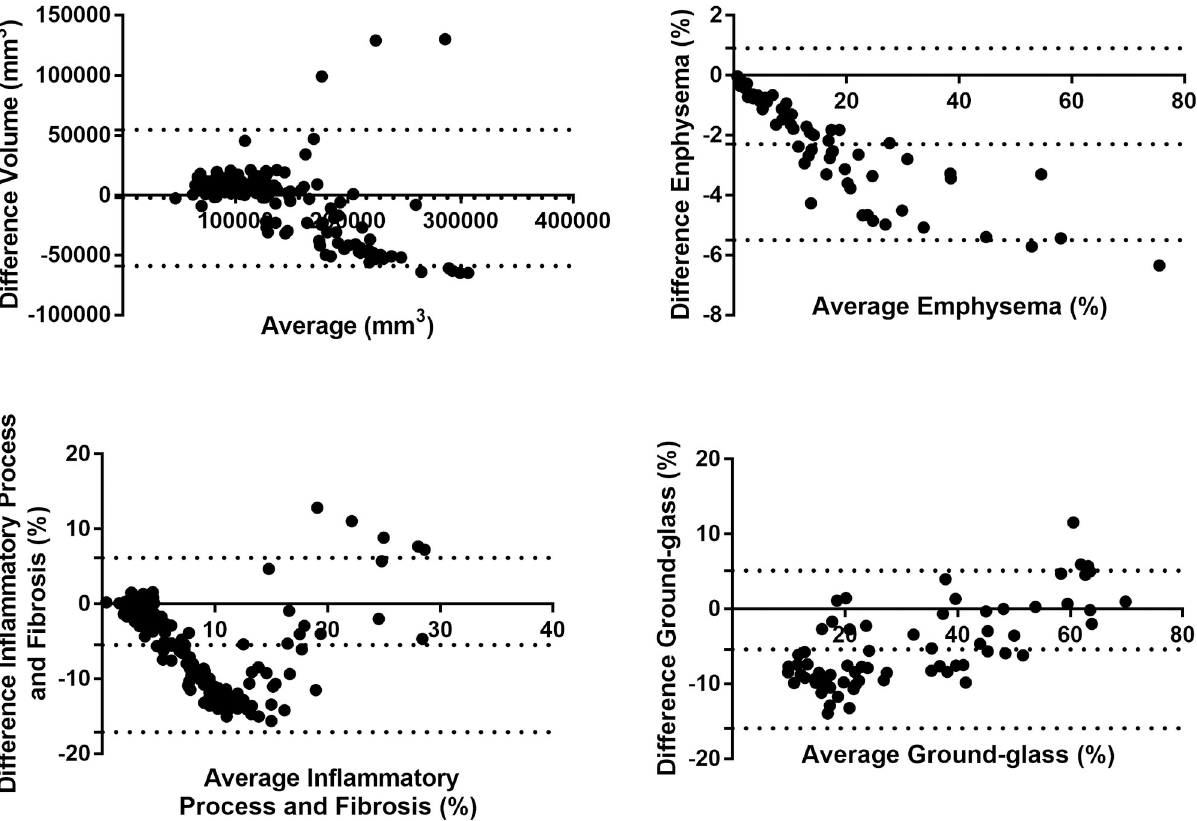
Fig 4. Bland–Altman plots comparing the difference the semi-automatic and the automatic algorithms. A—Lung volume, B—Emphysema, C— Inflammatory process and fibrosis, and D—Ground-glass opacities. Short dashed lines indicate the interval of 2 standard deviations, indicating an excellent level of statistical agreement between the